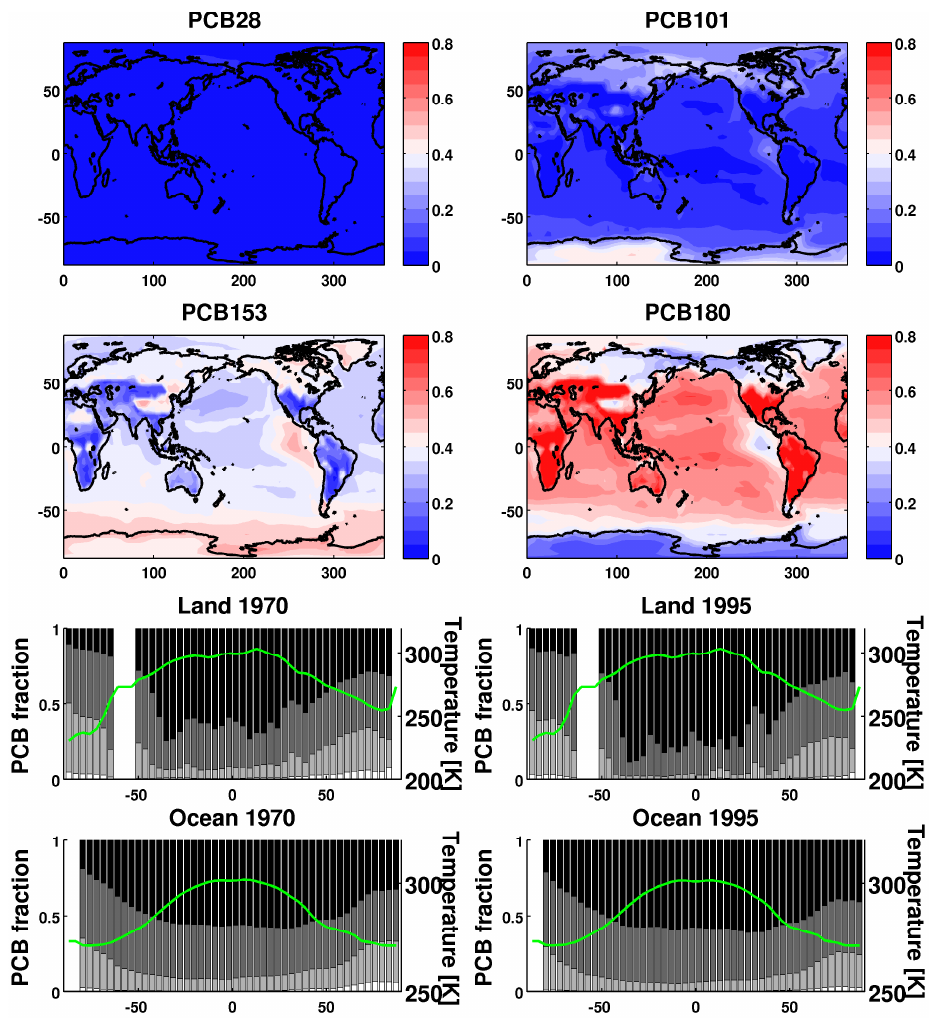
Fig. 6. Same as Fig. 5 but ground compartments, meridional trends for land (soil, vegetation, ice and snow) and ocean (seawater and sea ice) Fig. 6: Same as Fig. 5 but ground compartments, meridional trends on land (soil, vegetation, ice and together with surface temperature (green snow) and on sea (seawater and sea ice) together with surface temperature (green line)